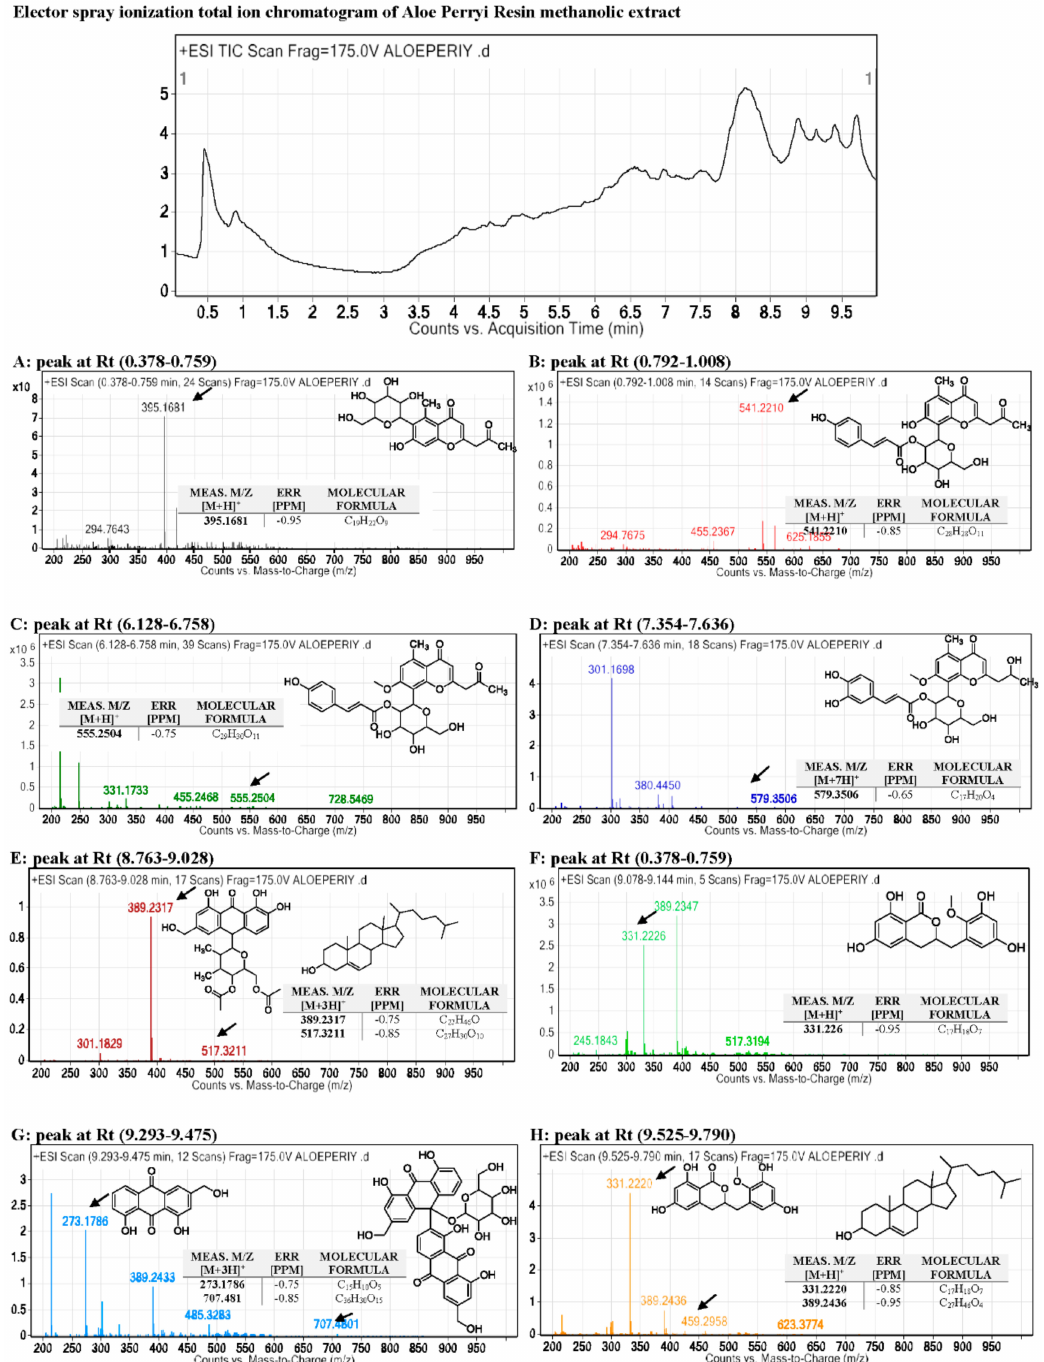
Figure 1. Base peak chromatogram of Aloe perryi crude extract and tentatively identified secondary metabolites, which are Isoaloesin ( A ), Nataloe emodin-8-methyl ester ( B ), 7 − O − Methylaloeresin A ( C ), Isorabaichromone ( D ), 7 − hydroxyaloin − 4 (cid:48) ,6 (cid:48) − O − diacetate and cholesterol ( E ), Aloe coumarin ( F ), Aloe emodin and glycosylated dimer derivative elgonicardine ( G ), Aloe coumarin and cholesterol ( H ) indicates that m / z implies measured m / z